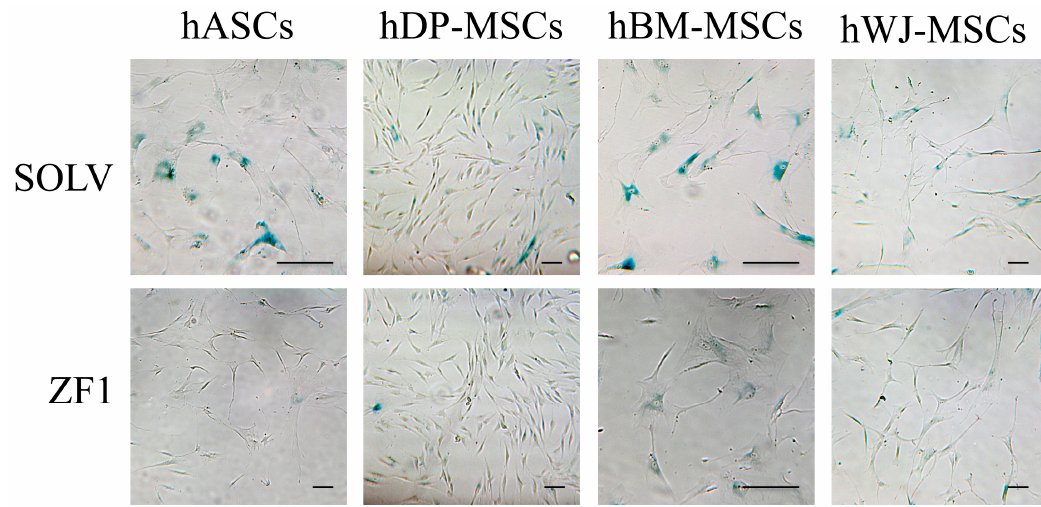
Figure 9. Representative images of the effects of ZF1 treatment on SA β -gal activity in hMSCs. The hMSCs from different sources (culture passages 5 th –7 th ) were treated with 20 μ g/mL ZF1 or with a solvent (SOLV) as a control, and then analyzed for SA β -gal expression (blue color, 200× magnification and bright field illumination). Images are representative of three separate experiments ( n = 3) for each hMSC type.